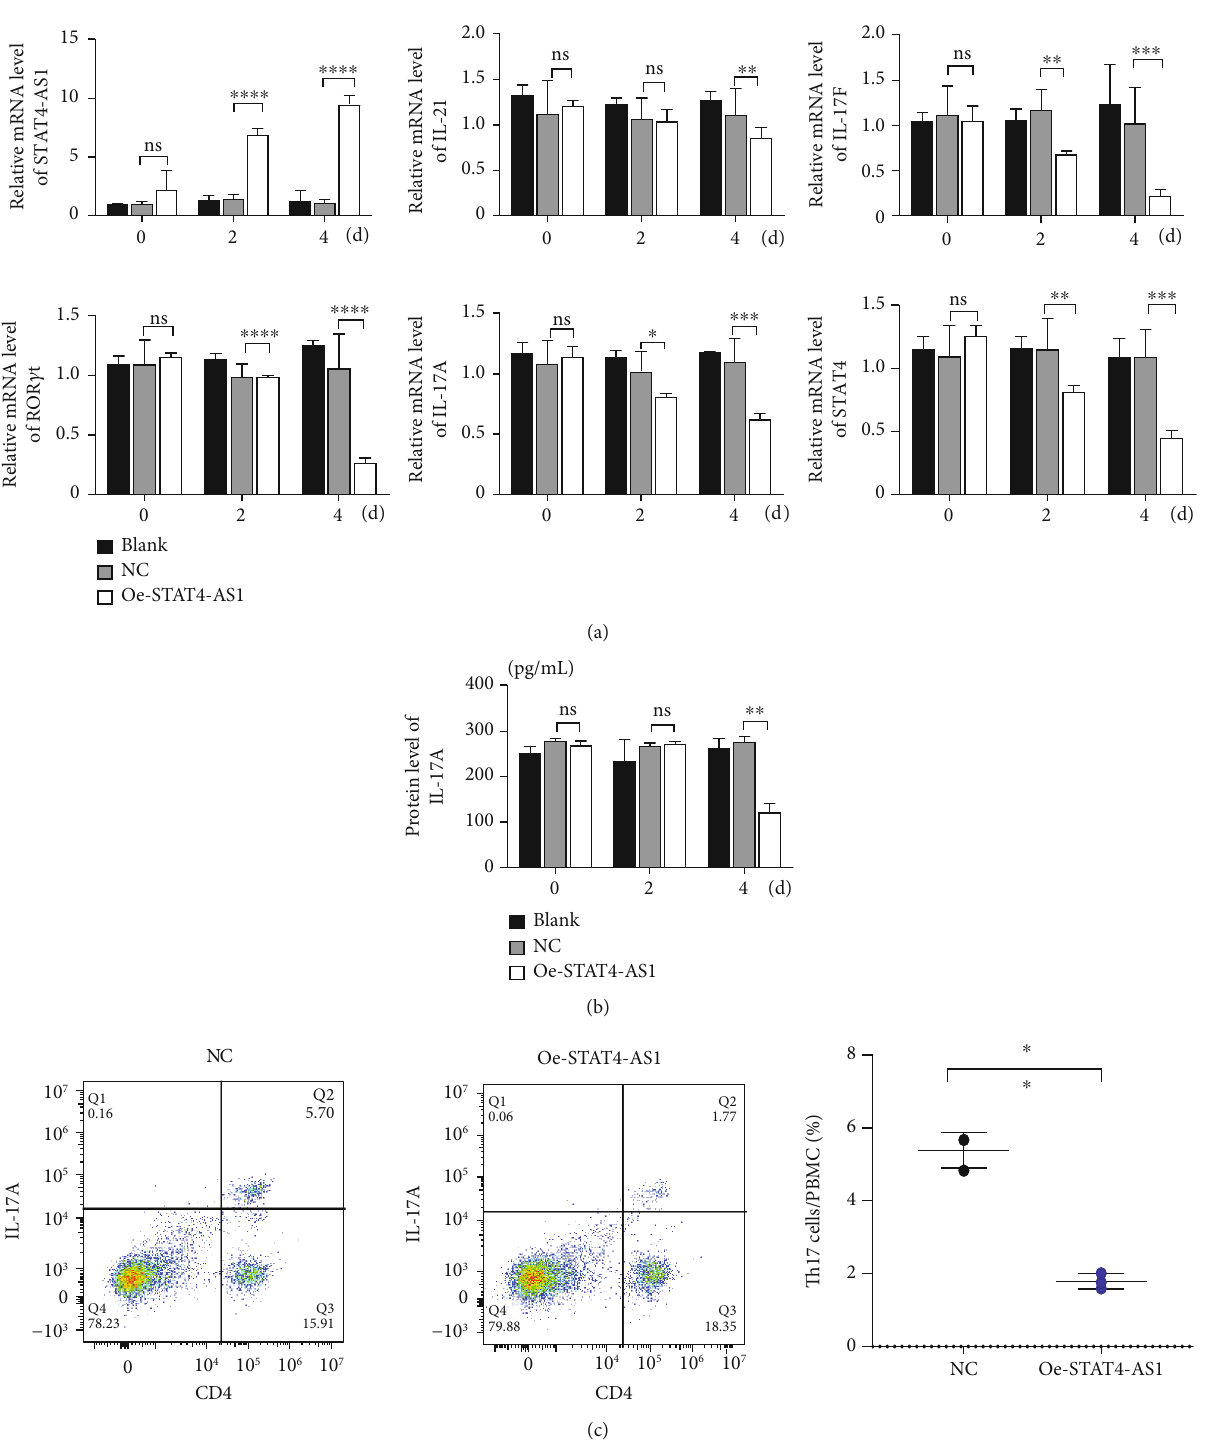
Figure 4: Upregulation of lncRNA STAT4-AS1 inhibited the di ff erentiation of TH17 cells. (a) The mRNA levels of lncRNA STAT4-AS1, STAT4, IL-17A, ROR γ t, IL-17F, and IL-21 on day 0, day 2, and day 4 after induction. (b) The level of IL-17A in the supernatant. (c) The proportion of TH17 cells after lncRNA STAT4-AS1 overexpression. Flow cytometry fi gures (left) and statistical analysis (right) of TH17 cells. Three independent experiments were performed, and data are presented as the mean ± SD . ∗ p < 0 : 05 , ∗∗ p < 0 : 01 , and ∗∗∗ p < 0 : 001